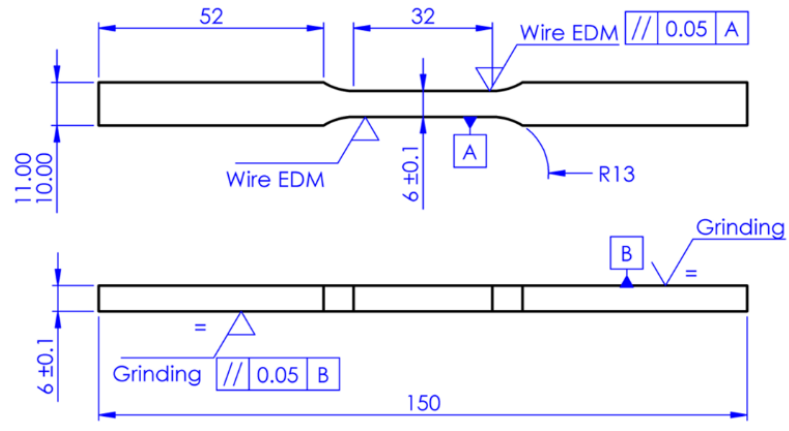
Figure 1. Test coupon geometry, dimensions and tolerances (in mm).